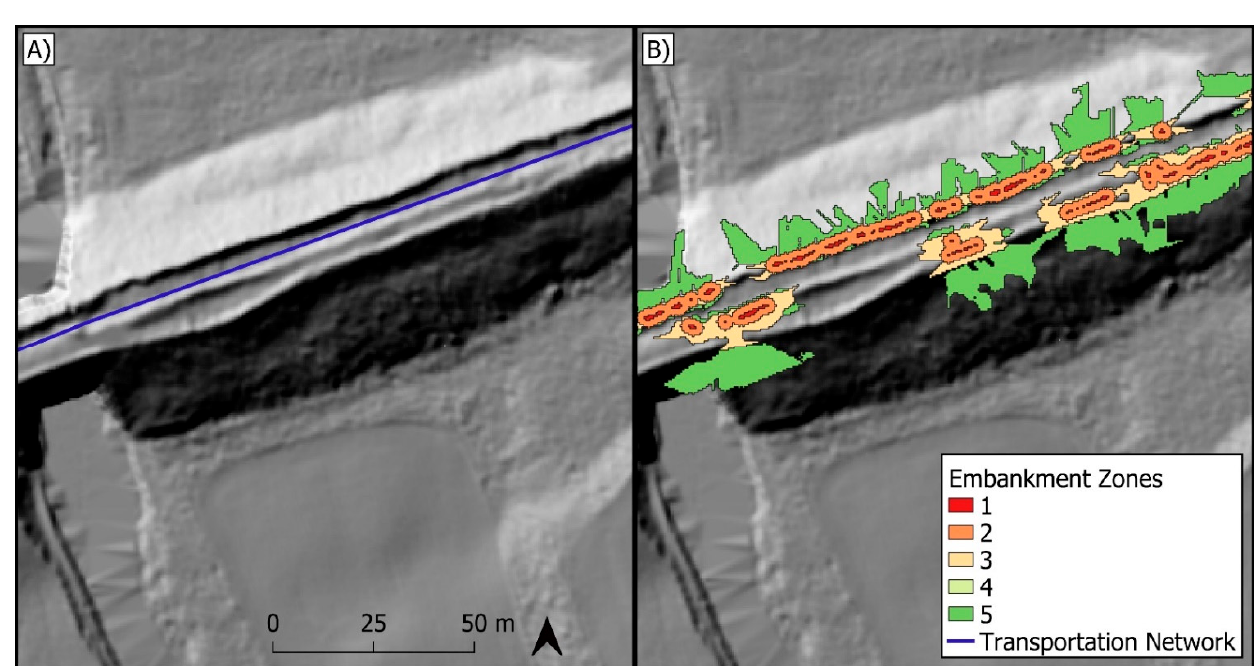
Figure 7. ( A ) Atypical morphology of an embankment at a valley crossing; ( B ) The embankment region classified by the algorithm. Figure 8 demonstrates the effect of removing mapped embankments and interpolating a surface in the data gaps left by the excised features. Data voids were filled using an inverse-distance weighted (IDW) interpolation technique.